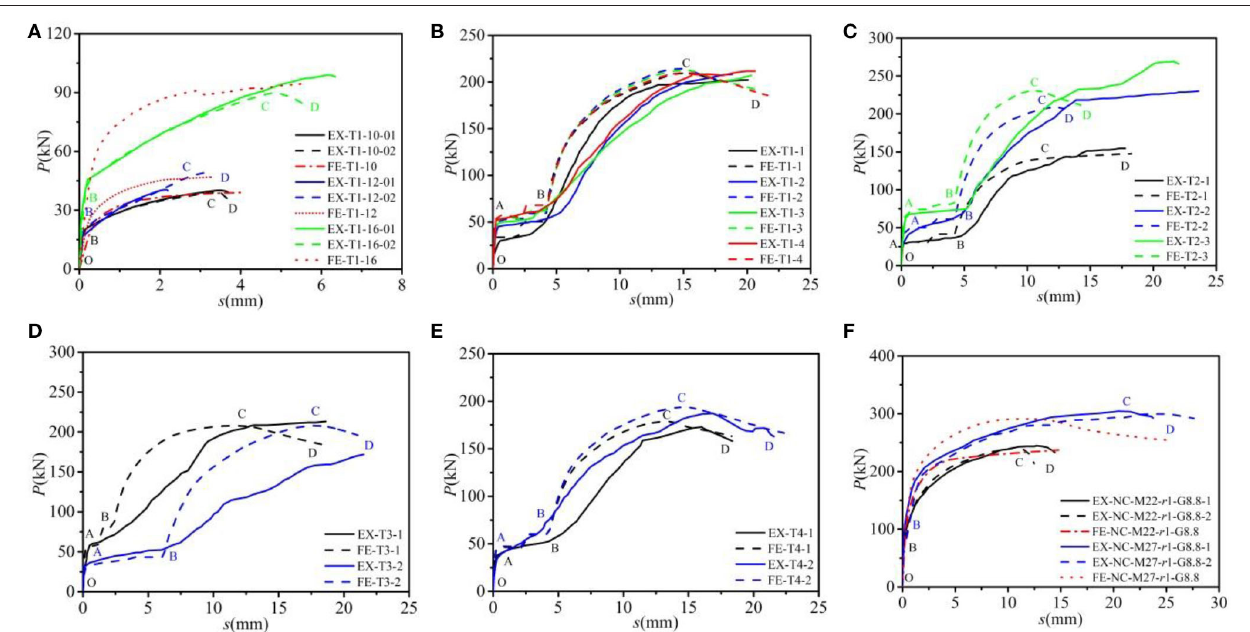
FIGURE 3 | Comparison of load–slip curves between the FEM and tested results (Chen et al., 2019; Zhang et al., 2019, 2020): (A) T1 group (Chen et al., 2019); (B) T1 group ( Zhang et al., 2019); (C) T2 group (Zhang et al., 2019); (D) T3 group (Zhang et al., 2019); (E) T4 group (Zhang et al., 2019); and (F) NC group (Zhang et al.,